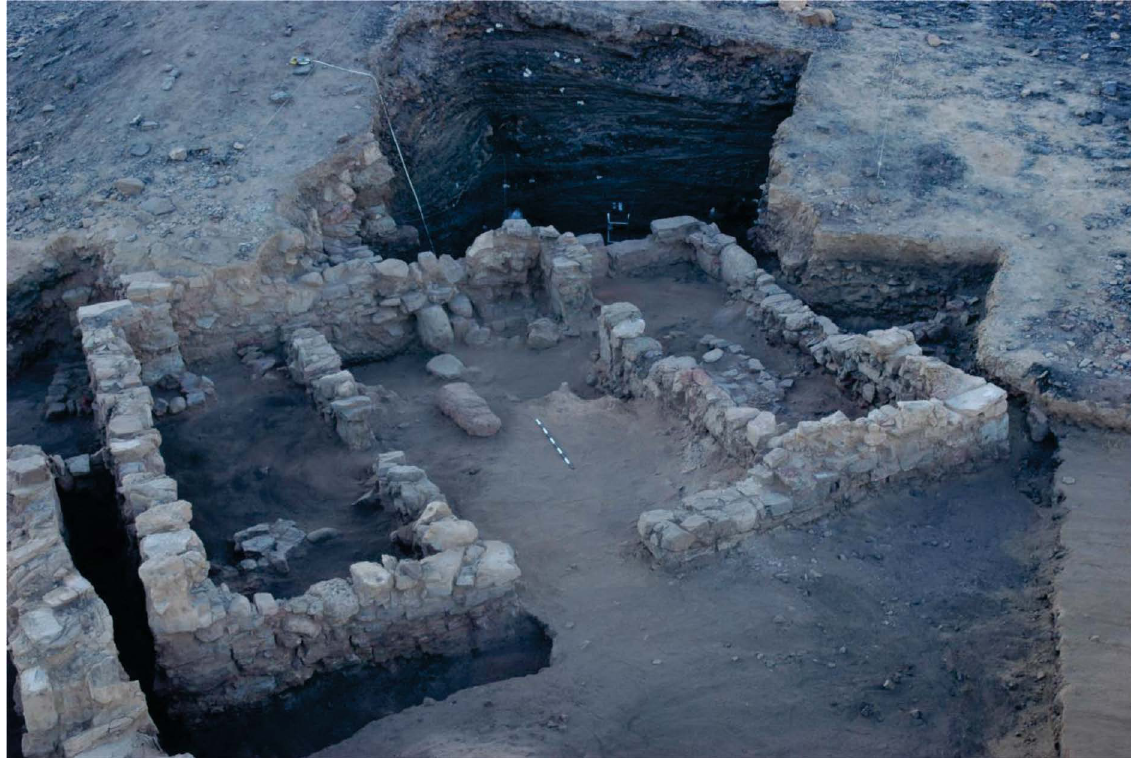
Figure 7. 2006 Khirbat en-Nahas excavation - Area M. (Source: Levy et al. 2014b.)